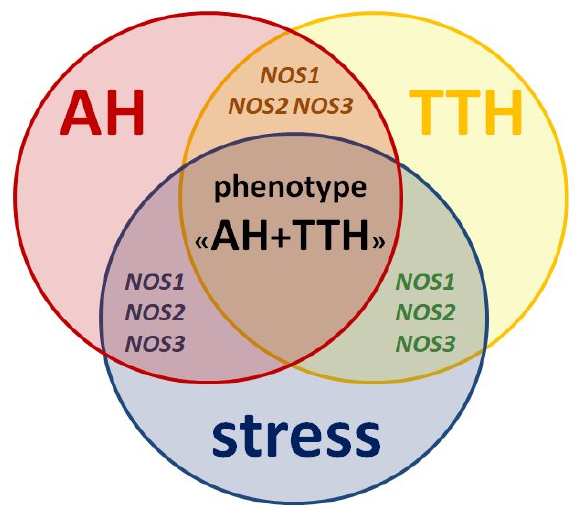
Figure 2. Similarities in pathogenesis and unresolved issues of the role of NOS1 , NOS2 , NOS3 genes as genetic predictors of the AH + TTH phenotype.